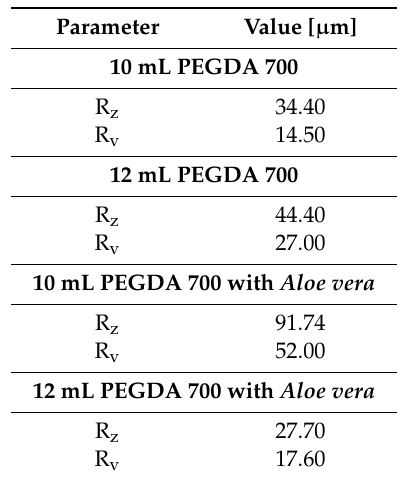
Table 6. Parameters of the surface roughness of analyzed hydrogels.